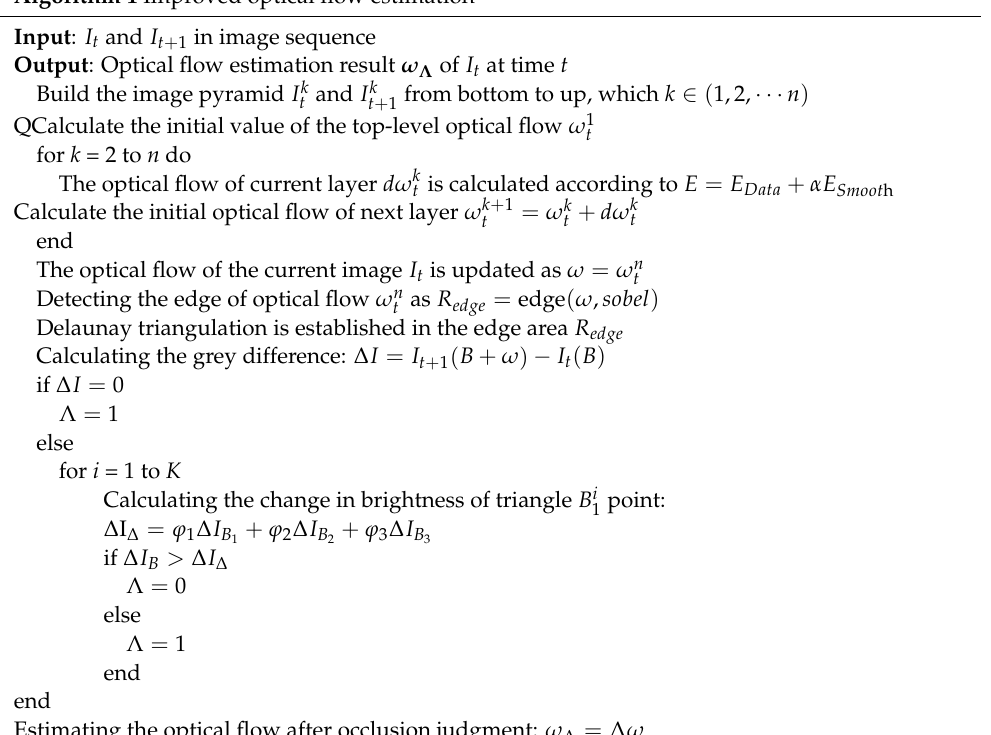
Algorithm 1 Improved optical flow estimation